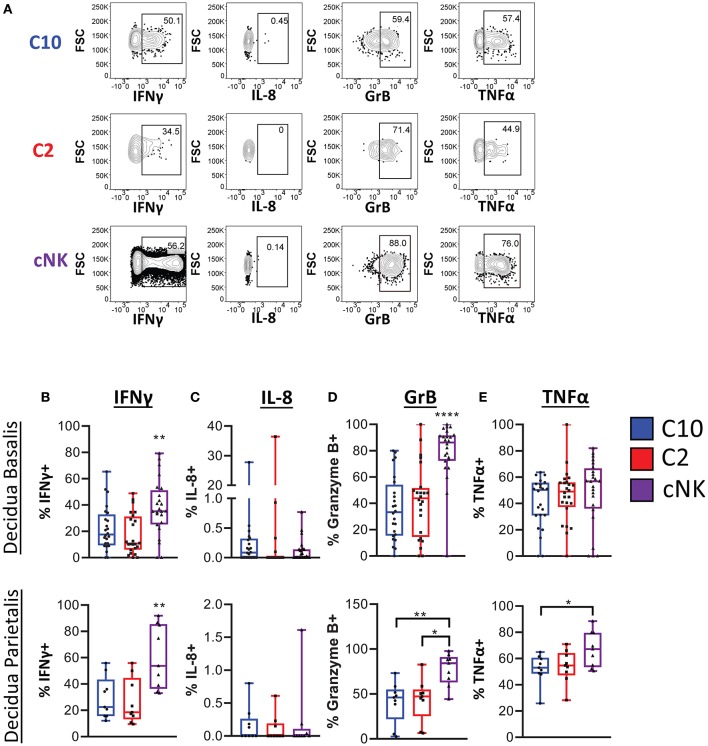
Cytokine production by novel ILCs. C10 and C2 skew towards NK-type cytokines. Lineage Negative (CD3, CD14, CD19), CD34−CD45+ cells were activated with PMA/Ionomycin for 6 h. Cytokine production was assessed via intracellular labeling. (A) Representative gating scheme of CD56Bright CD94+CD16−CD127−CD49a− (C10), CD49+ (C2), and of CD56DimCD16+CD127−CD117− from the decidua basalis showing NK type cytokine production (B–E) Quantification of NK type cytokine production by C10, C2, and cNK. Decidua basalis, n = 24; decidua parietalis, n = 9. Data represented as max/min, median, and 25 and 75th percentiles. Statistical significance was determined by ANOVA, followed by Tukey post-hoc tests. *p < 0.05, **p < 0.005, ****p < 0.00001. For statistical details see Supplementary Table 5. Data is provided in Data Sheet 1.